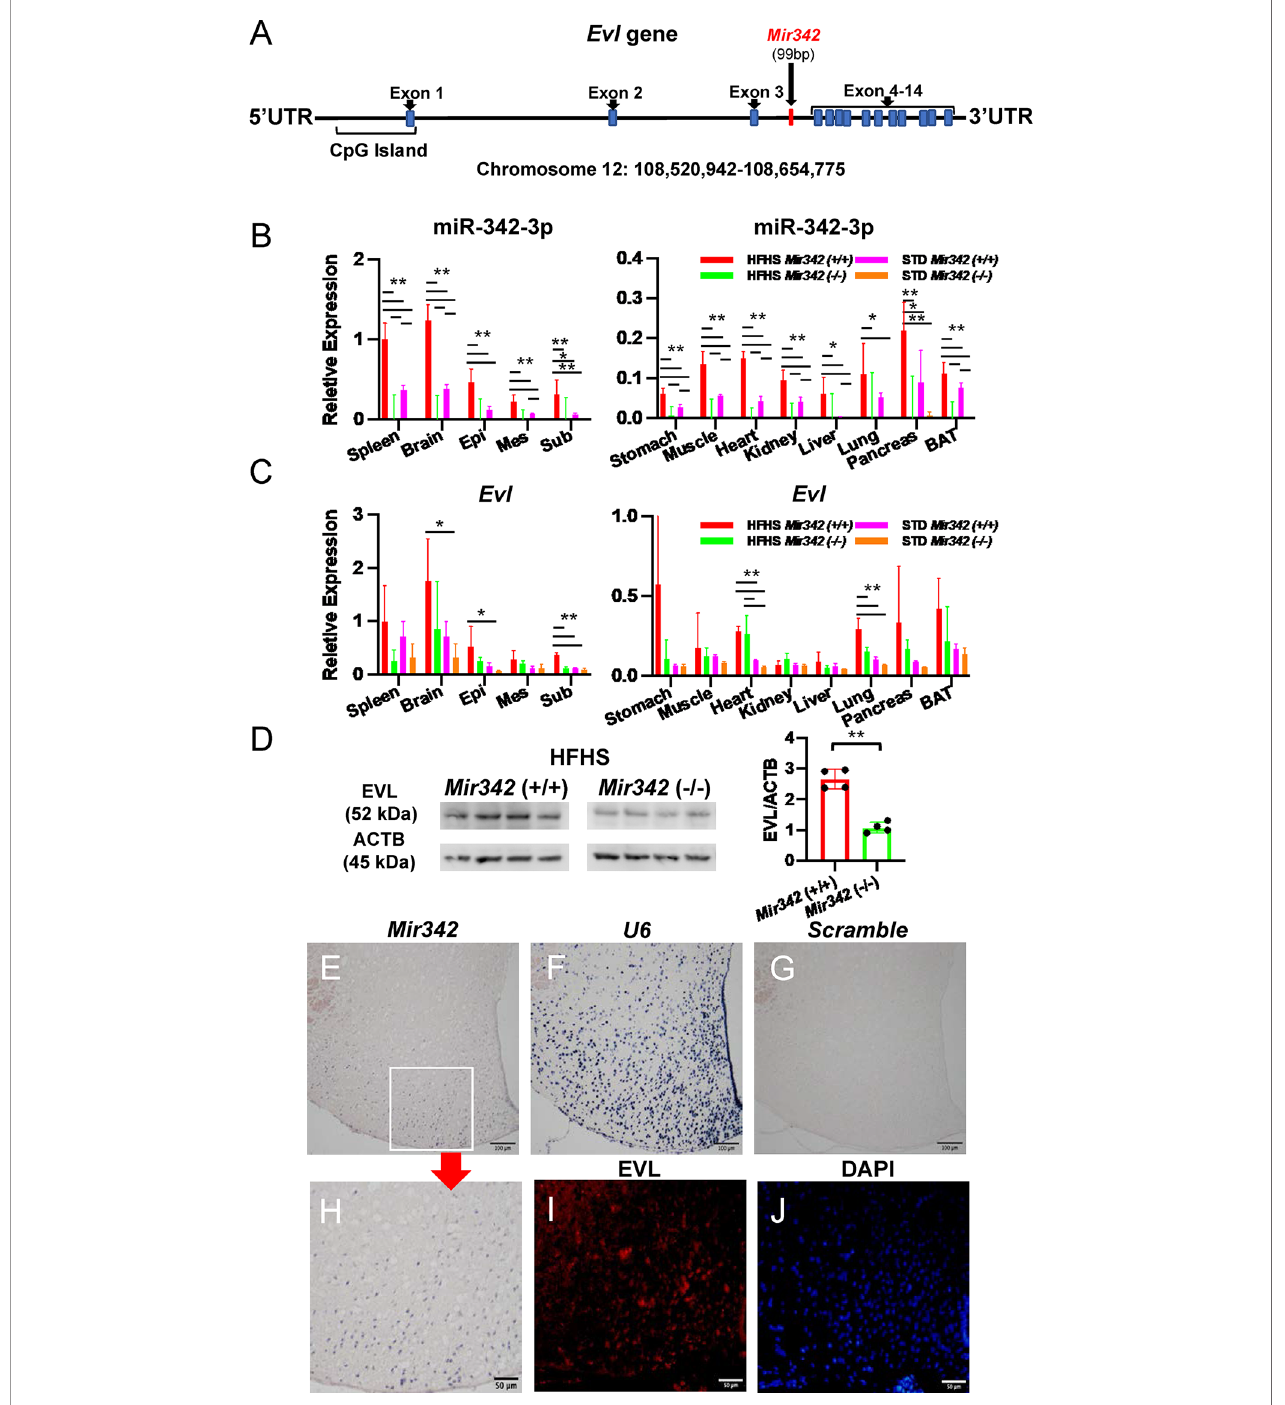
FIGURE 4 | Expression of Mir342 and its host gene Evl . (A) Mir342 is an intronic miRNA in Evl (Enabled/Vasodilator-stimulated phosphoprotein) gene. (B, C) In various tissues, the expression of miR-342-3p is normalized by snoRNA202 and snoRNA234, while Evl is normalized by Rplp0 and Rn18s . HFHS Mir342 (+/+) (n=4), HFHS Mir342 (-/-) (n=3), STD Mir342 (+/+) (n=4) and STD Mir342 (-/-) mice (n=4). Bar=100 m m. Data are analyzed by one-way ANOVA with a Tukey test. (D) Western blot analyses and quanti fi cation of EVL protein levels of brain tissue normalized by b -actin (ACTB). Data are analyzed by independent t -test. (E – H) In in situ hybridization, the sections of hypothalamus from Mir342 (+/+) mice were hybridized with Mir342 probe ( E ; Mir342 ), U6 snRNA probe ( F ; U6 ), and Scramble-miR probe ( G ; Scramble ). The inset in (E) is shown in panel (H) . Immunostaining of EVL (red) in hypothalamus of Mir342 (+/+) mice (I) and nuclear staining of DAPI (blue) (J) are shown. Bars are 100 and 50 m m in panels (E, H) , respectively. Data presented as means ± SD (*p < 0.05; **p < 0.01).